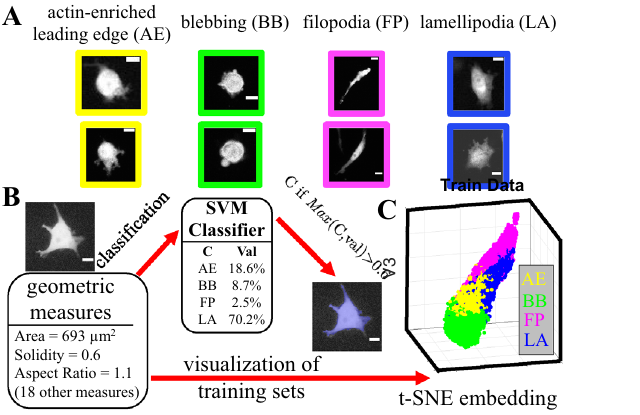
Figure 2. Development of a supervised machine learning model to classify cells into morphological phenotypes corresponding to different migration modes. ( A ) MDA-MB-231 cells in 3D collagen matrices exhibit multiple morphological phenotypes that are characteristic of four distinct migration modes: actin-enriched leading edge (AE), small blebbing (BB), filopodial (FP), and lamellipodial (LA). Scale bars are 20 µ m. ( B ) The cell images are quantified using a total of 21 geometric measures such as area, solidity, and aspect ratio. With 3800 manually labeled single cell images we have trained a supported vector machine (SVM) to calculate probability scores (Val) for a cell to belong to each morphological phenotypes (classes). We assign a cell to the class C with the maximum score ( Max ( C , val )), if this maximum score is greater than a threshold of 60% ( Max ( C , val ) > 0.6 ). We consider a cell to be at an intermediate state if none of the four classes have a score higher than 0.6. In ( B ) a sample cell image is classified as a lamellipodial cell (LA), because LA class has a score of greater than 0.6. ( C ) To better visualize the high dimensional geometric measures, we apply t-SNE method to generate a 3D projection of the geometric cell shape space. 15,000 unseen data set is presented here. Different morphological phenotypes are well separated. AE (yellow): actin-enriched leading edge. BB (green): small blebbing. FP (magenta): filopodial. LA (blue): lamellipodial. This figure is prepared with Matlab R2020a (www. mathw orks. com) and ImageJ (https:// imagej.